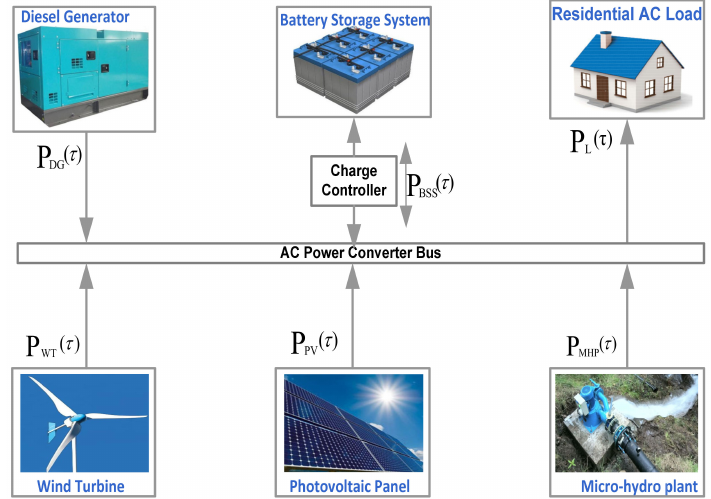
Figure 3. A network structure of the proposed distributed energy